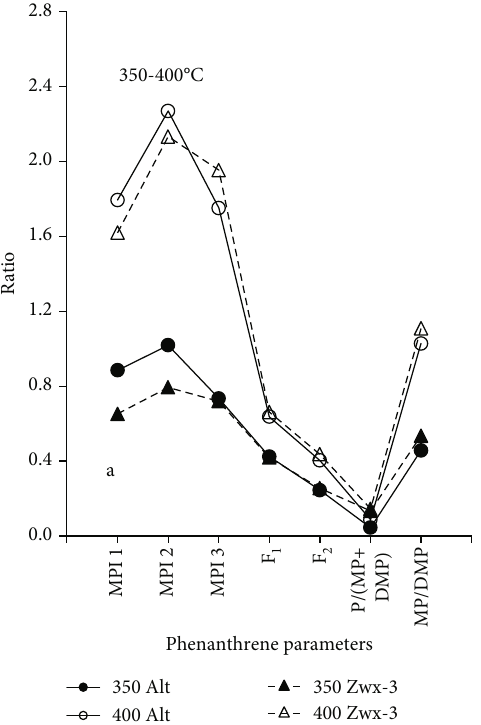
Figure 5: Distributions of phenanthrene parameter values in the pyrolysis samples (P: phenanthrene; MP: methylphenanthrene; DMP: dimethylphenanthrene; MPI1: 1.5(2-MP+ 3-MP)/(P+ 9-MP+1-MP); MPI2: 3(2-MP)/(P+9-MP +1-MP); MPI3: (3-MP+ 2-MP)/(9-MP : (2-MP +3-MP)/(2-MP +3-MP+ 1-MP+9-MP); F : 2-MP/(2-MP +3-MP+ +1-MP); F 1 2 Table 4: Discrepancy in mean δ D value between methane and PAHs, n -alkanes and PAHs, and PAHs in the pyrolysis samples. Temperature ( ° C)